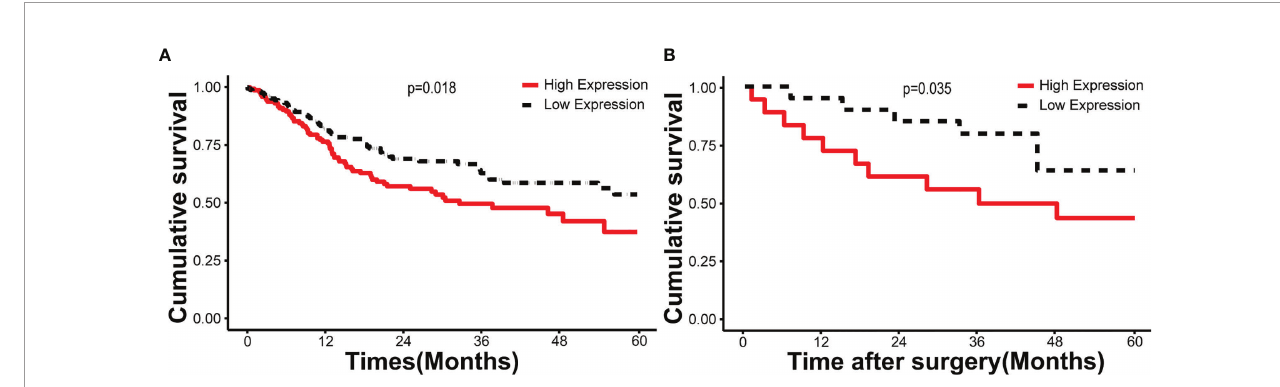
FIGURE 5 | HNRNPA2B1 is associated with prognosis in patients with OSCC. Kaplan – Meier survival of (A) 330 cases from the TCGA database and (B) 38 patients from our department.